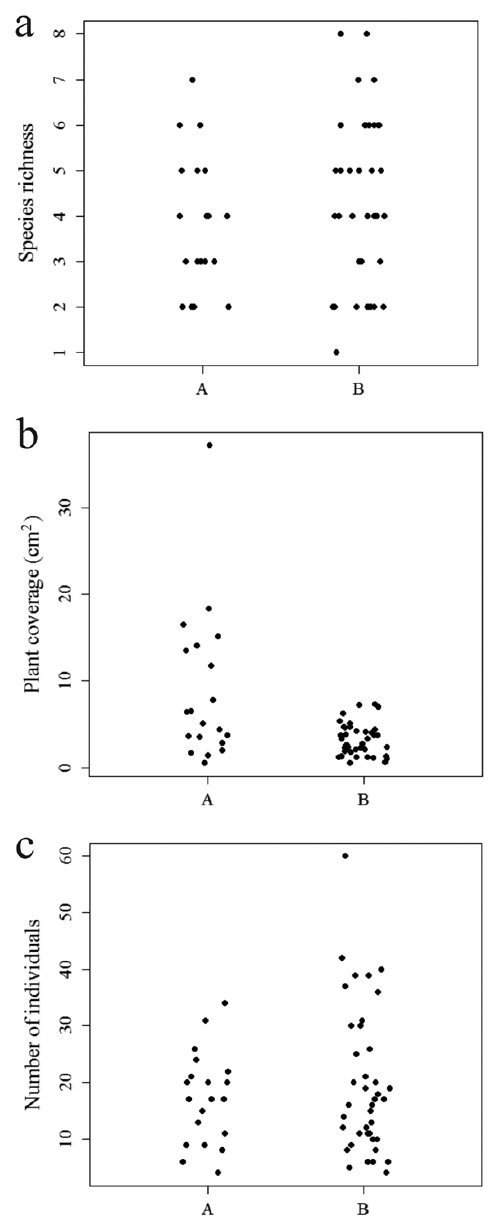
Fig. 3 - Ferns and Lycophytes species (a) richness, (b) plant cover and (c) abundance at sites A and B. Points represent the raw values recorded at the plots on each